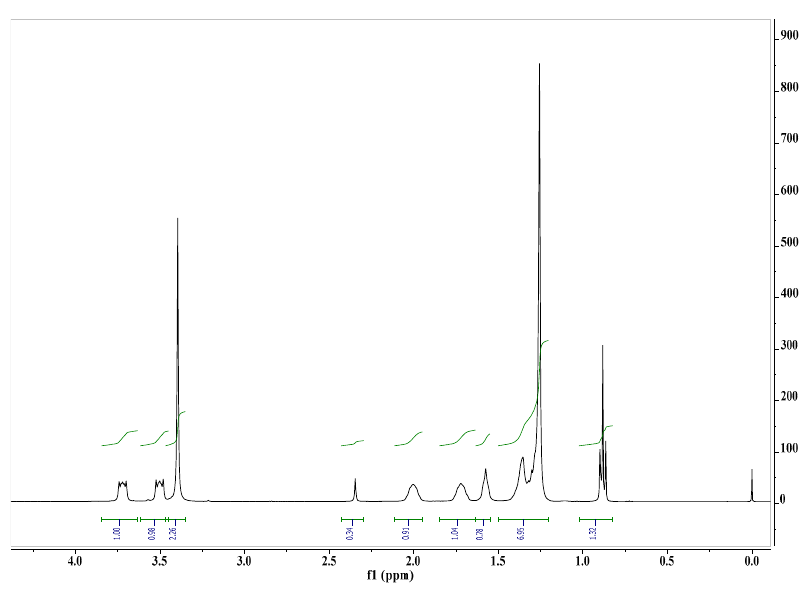
Figure 3. 1 H-NMR spectrum of hexamethylene-1,6-bis( N , N -dimethyl- N -dodecylammonium bromide) in CDCl 3 .